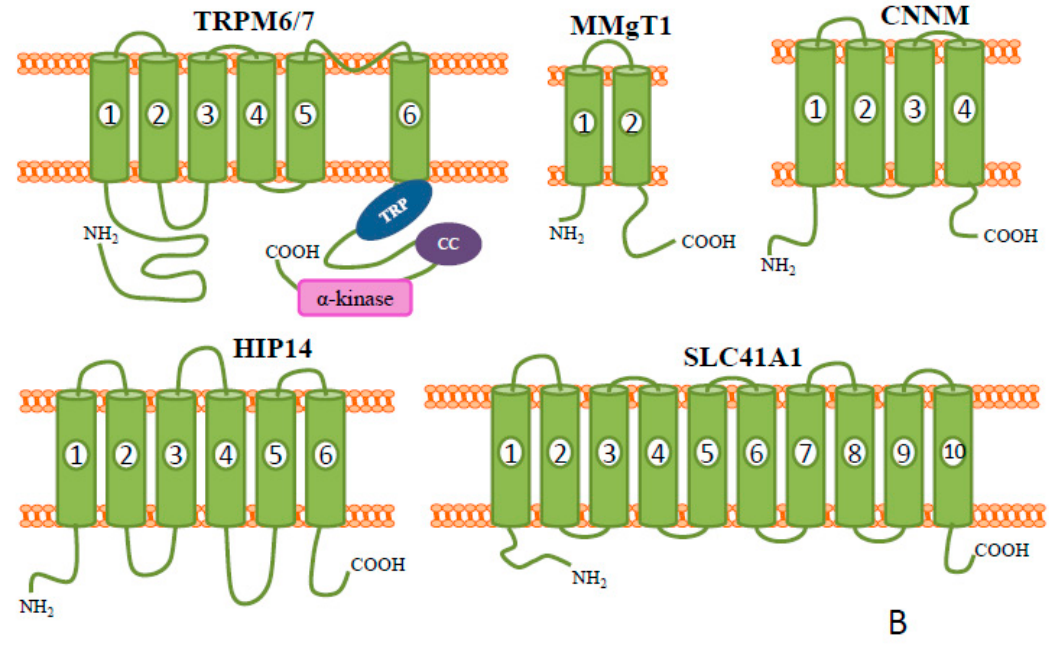
Figure 1. Schematic diagrams of the representative members of mammalian ( A ) selective and ( B ) non-selective Mg 2 +